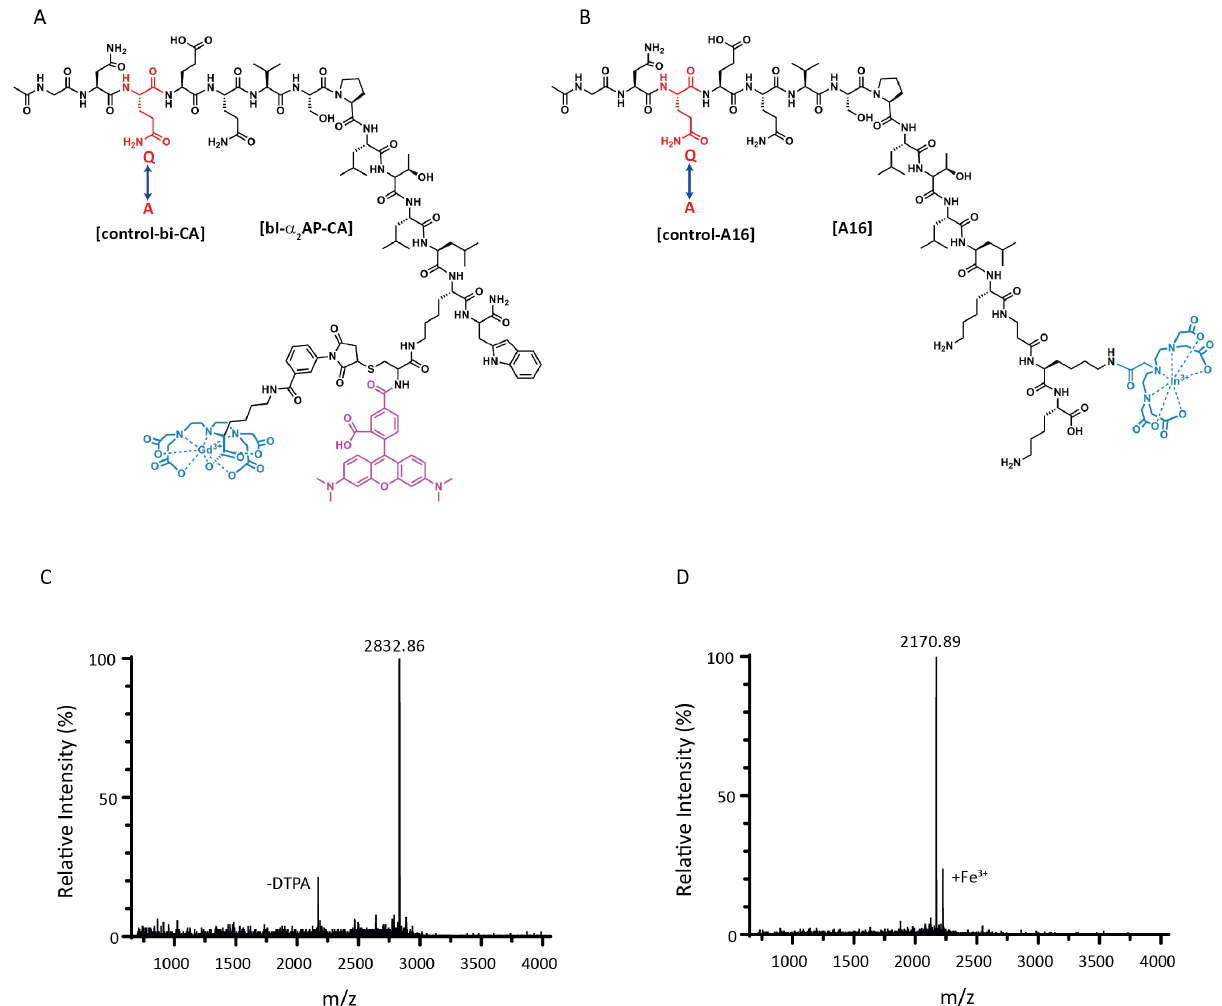
Figure 1. Schematic representations of the previously developed bi- α 2-AP-CA ( A , modified from [25]), and the optimized probe A16 ( B ), which is conjugated to the chelator DTPA (blue), enabling labelling with 111 In. Substitution of glutamine to alanine (Q3 → A3) leads to a control probe (control-bi-CA or control-A16, respectively), which does not bind to fibrin ( C , D ). Mass spectra of bi- α 2-AP-CA and A16, respectively, showing a mass of 2832.86 and 2170.89 (calculated masses: 2832.92 and